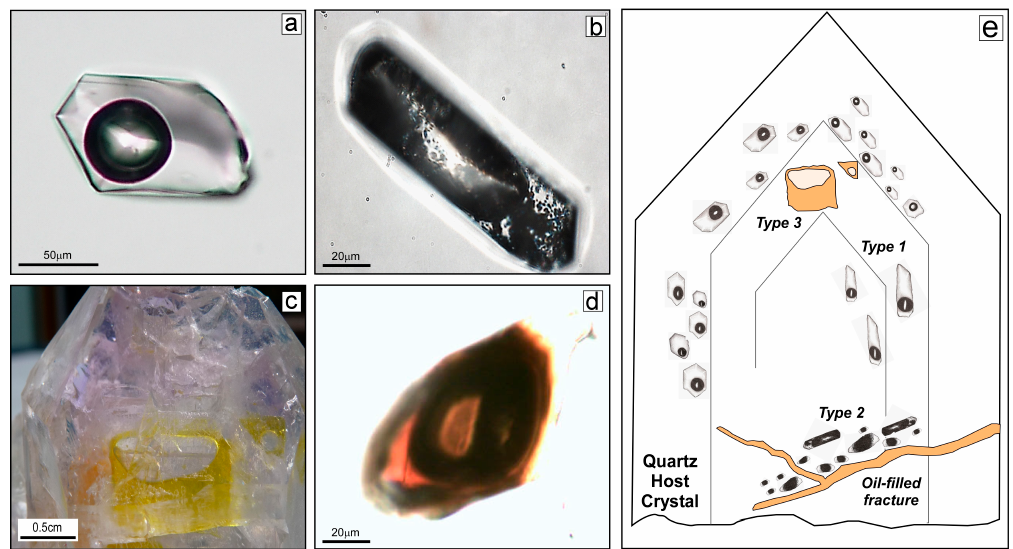
Figure 3. Photomicrographs in plane polarised light (PPL, ( a , b , d )) and a photograph of a hand sample ( c ) of the different fluid inclusion (FI) types observed ( a ) Type 1 inclusion; ( b ) Type 2; ( c , d ) Type 3; ( e ) Schematic representation of a quartz amethyst crystal showing the spatial relationships between the FI types and the crystal growth zones. An amber coloured oil-filled fracture crosscutting Type 2 FIs is also shown.